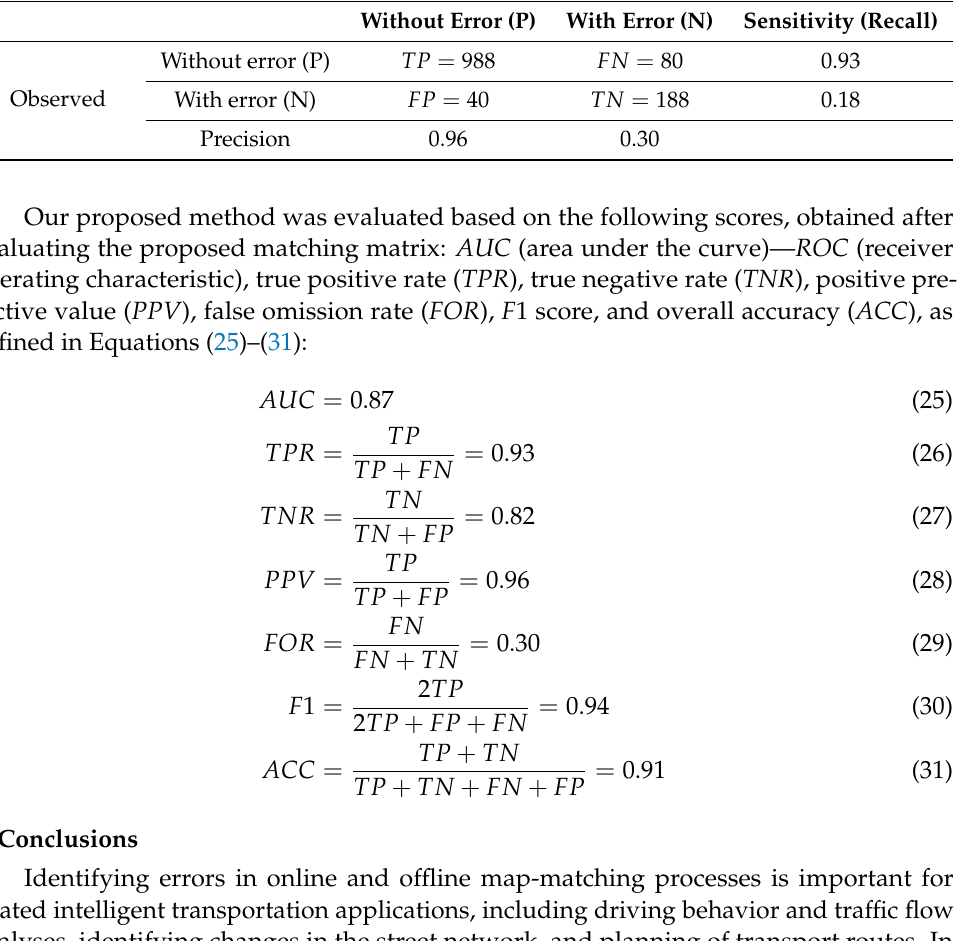
Table 2. Matching matrix generated using the proposed method.